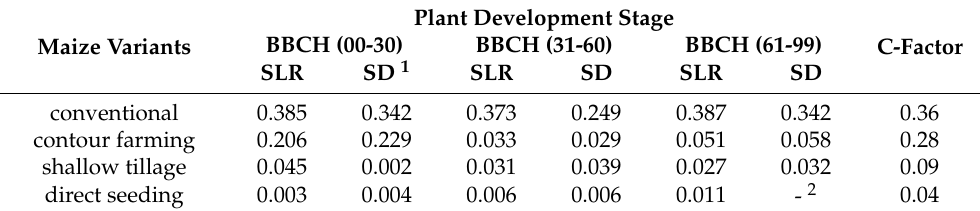
Table 4. SLR values for maize farming variants, average of dry and wet conditions. Plant Development Maize Variants